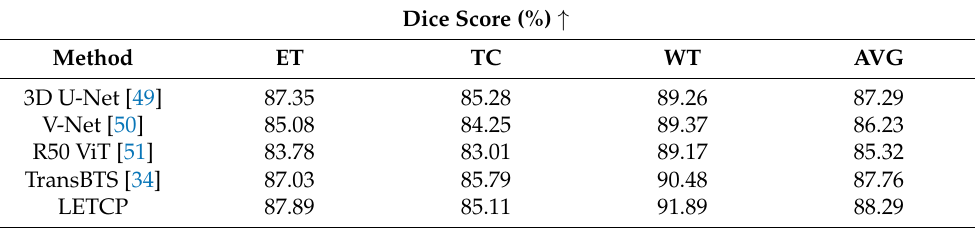
Table 3. Dice Score results comparison of LETCP and baselines on BraTS 2019 [1,3,48]. ↑ means higher is better.